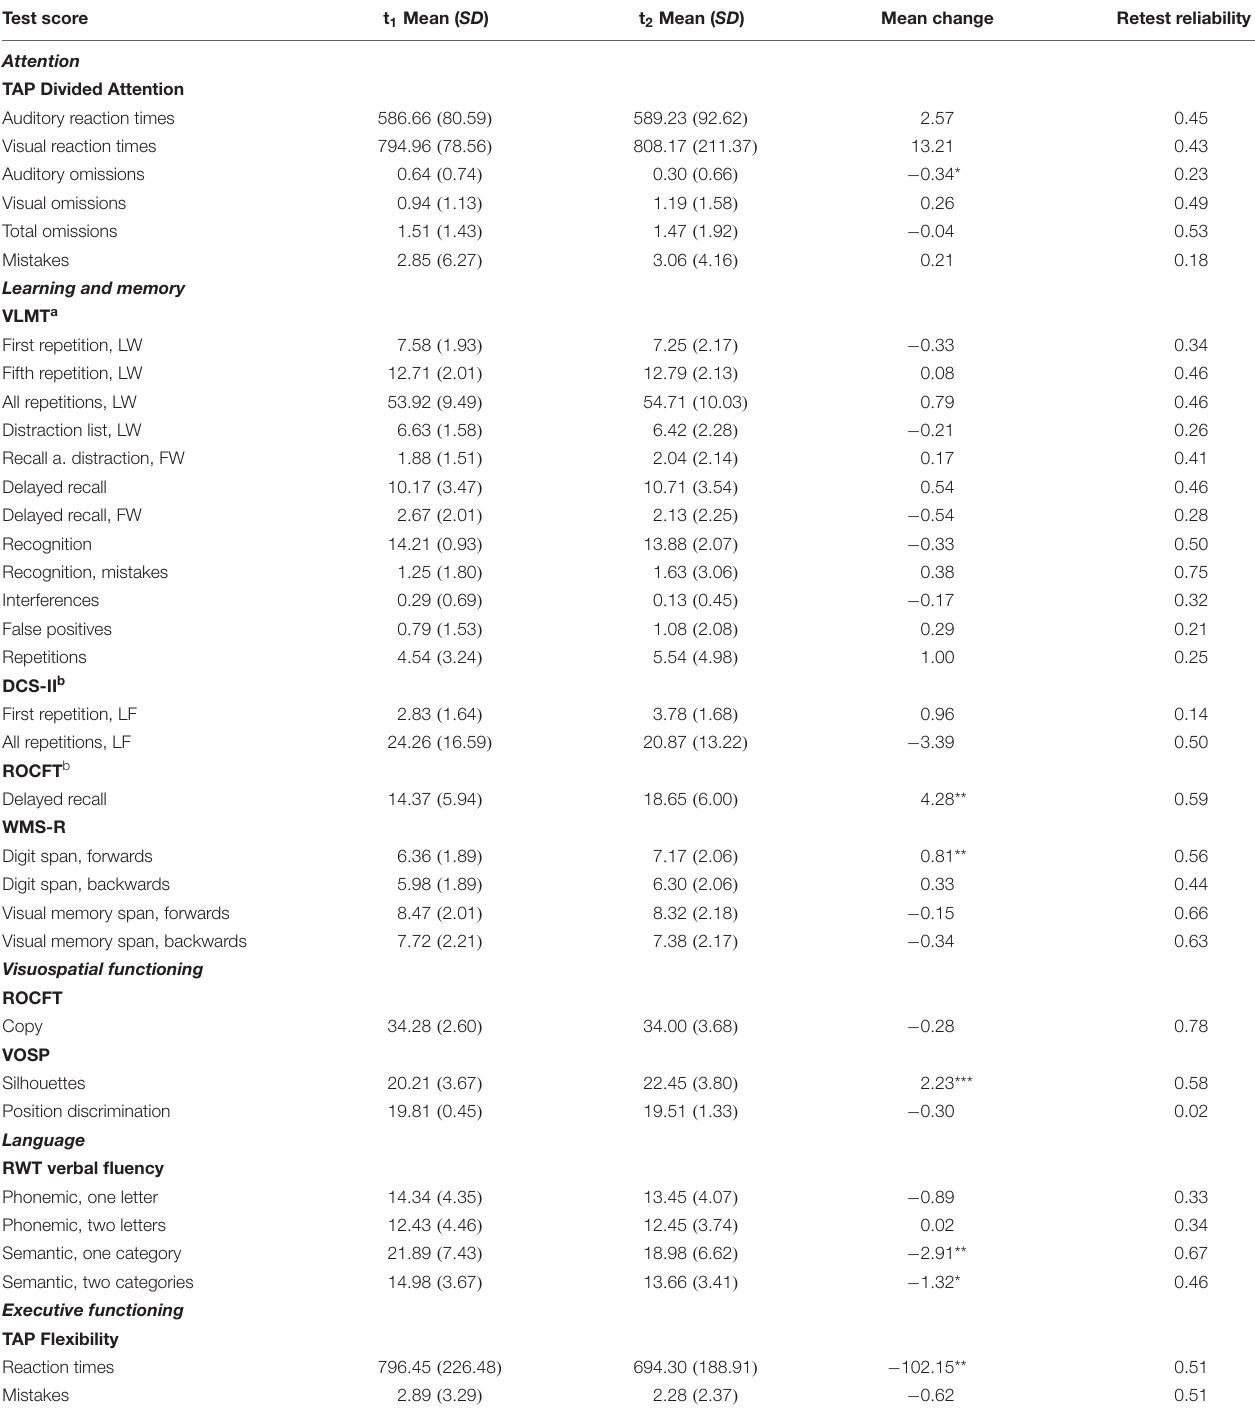
TABLE 2 | Mean raw scores, standard deviation ( SD ) and mean change between t 2 and t 1 (compared by paired samples t -tests) together with retest reliability coefficients for each test score and scale. Test